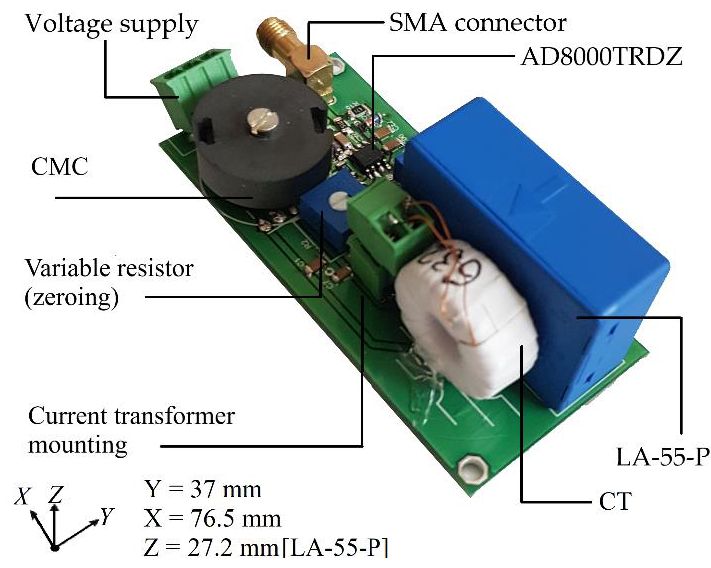
Figure 3. Prototype of the proposed sensor—PCB realization of ALCS.